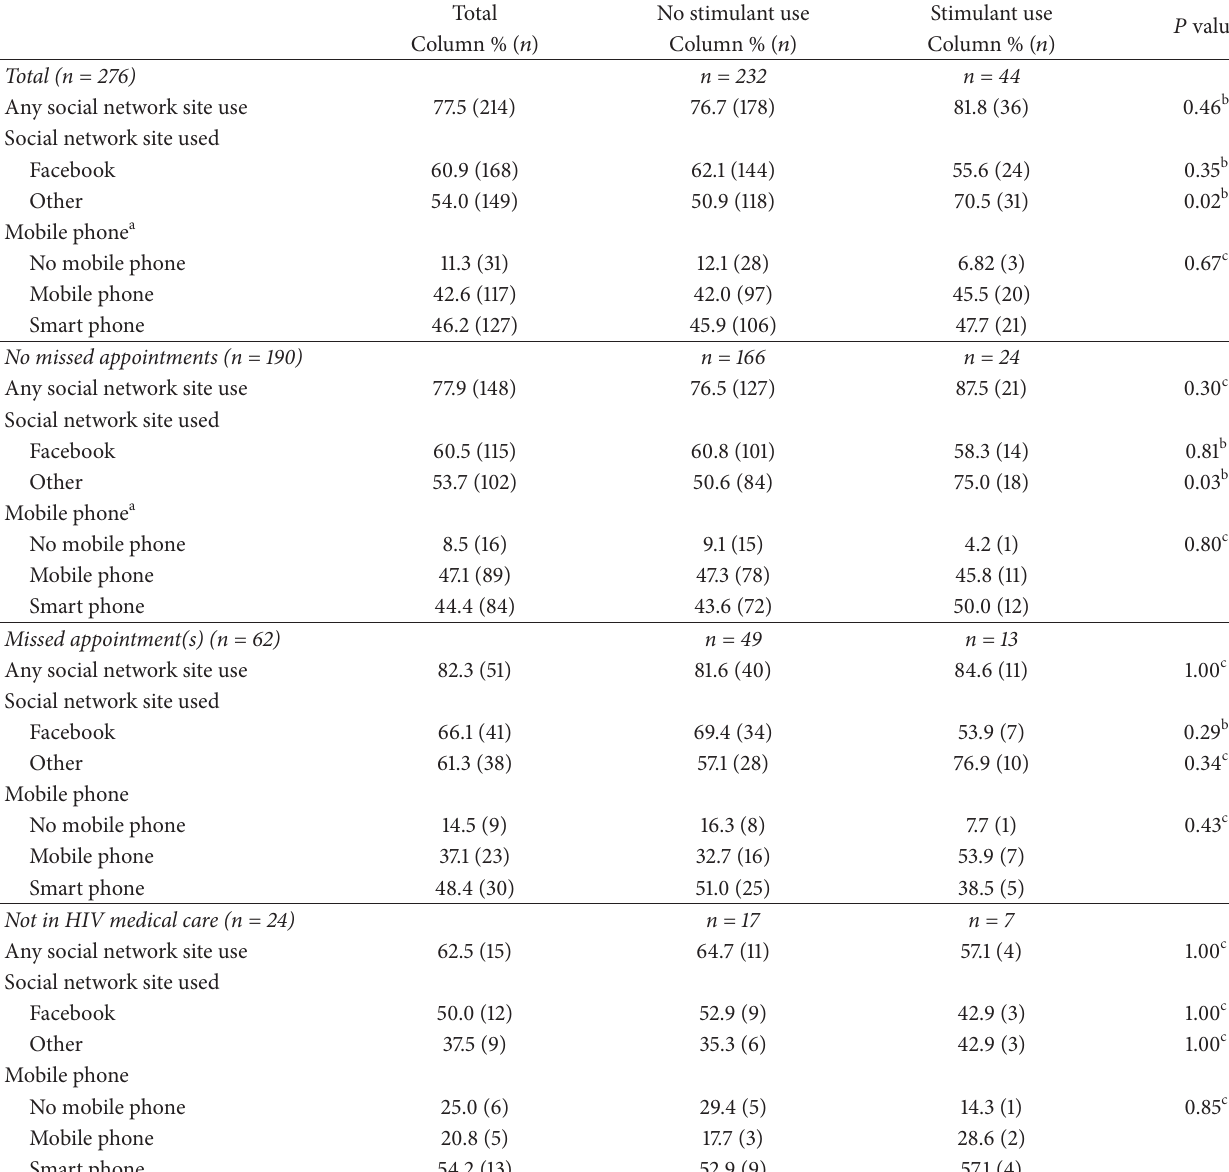
Table 4: Technology use by stimulant use and engagement in HIV